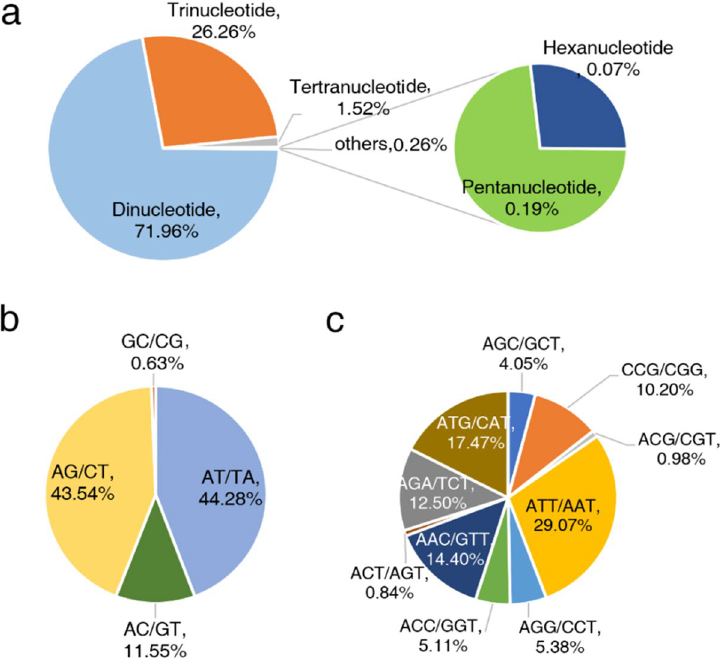
Figure 2. Identification and characteristics of SSR motifs. ( a ) Frequency of different SSR motif types. ( b ) Frequency of different dinucleotide SSRs motifs. ( c ) Frequency of different trinucleotide SSR